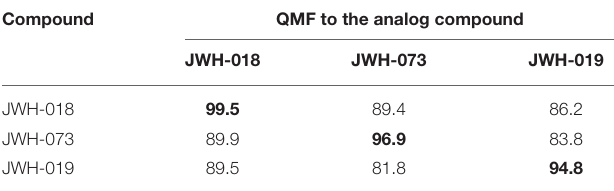
TABLE 2 | QMF for JWH-018 and its related compounds. Compound QMF to the analog compound JWH-018 JWH-073 JWH-019 JWH-018 99.5 89.4 86.2 83.8 89.5 81.8